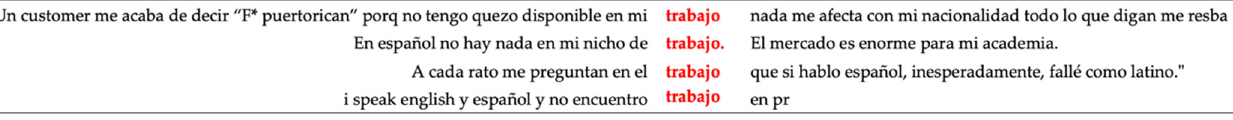
Figure 5. Concordance lines for trabajo that indicate negative attitudes on the status dimension.